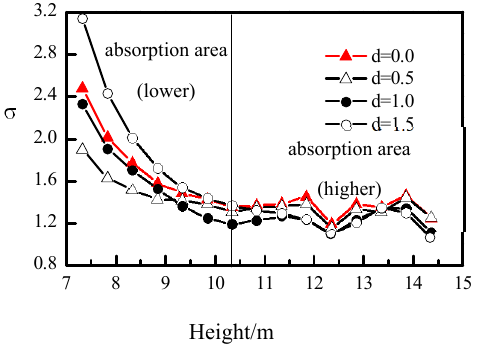
Figure 8. Velocity standard deviations of the representative section.